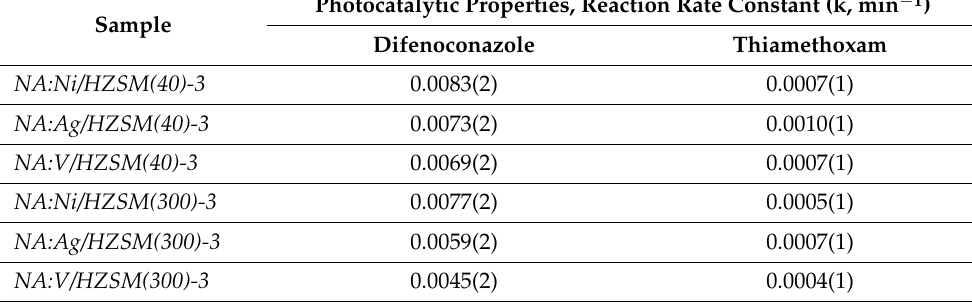
Table 7. Functional properties of NA:M/HZSM(40)-3 and NA:M/HZSM(300)-3 (data from [65]).